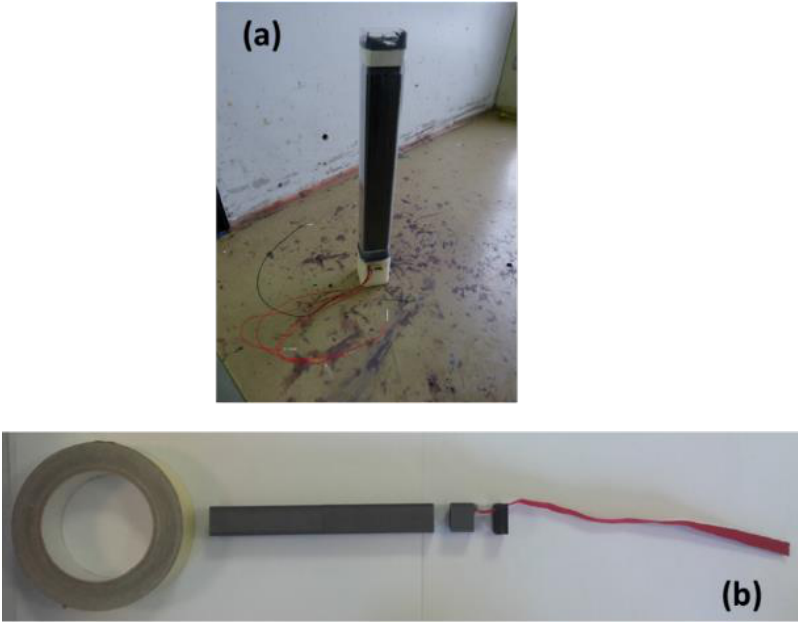
Figure 7. Smart IR flare prototypes ( a ) using conventional electrical wires for testing. ( b ) using electrical wrapped